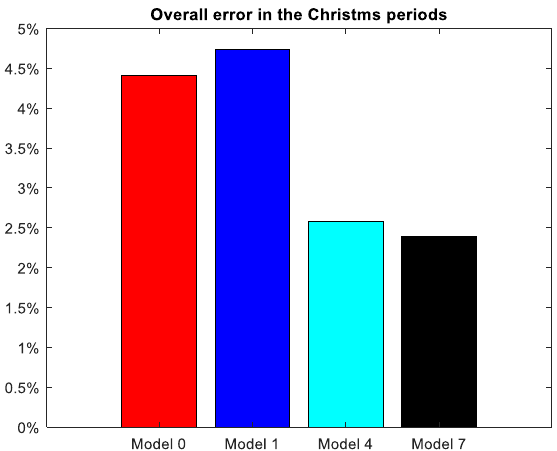
Figure 14. MAPE for models 0, 1, 4 and 7 for all days included in the three Christmas periods.